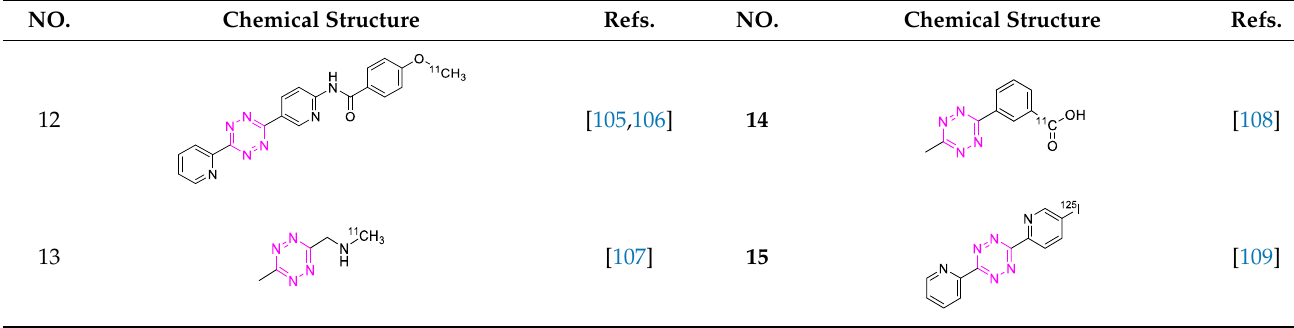
Table 3. Overview of 11 C- and 125 I-labeled Tzs.